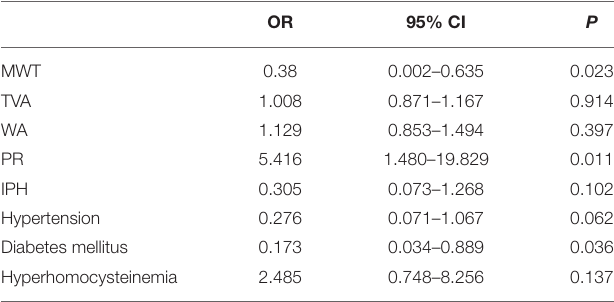
TABLE 4 | Results of multivariable regression analysis showing factors associated with sICAS in the young